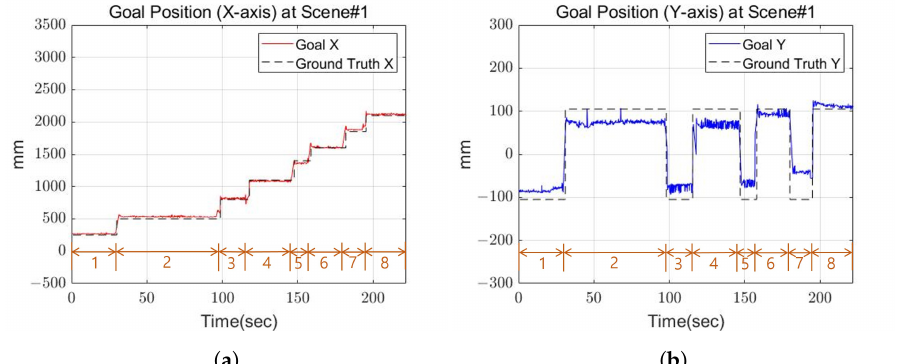
Figure 14. The goal position of Scene 1. ( a ) X-axis goal position at Scene 1; ( b ) Y-axis goal position at Scene 1.